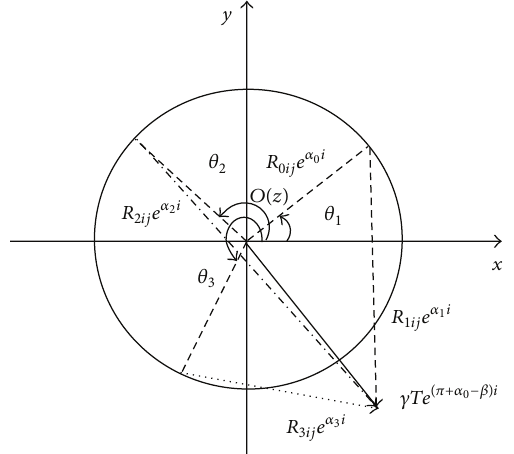
Figure 2: Schematic diagram of triple phase method.